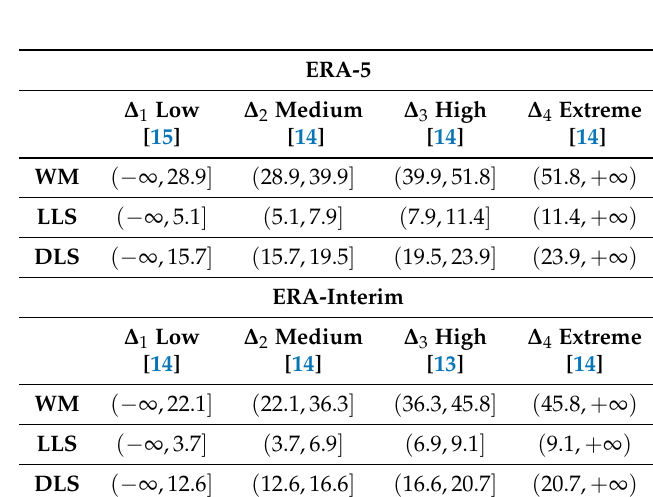
Table 1. The sub-intervals ∆ i ’s used to partition the ranges spanned by WM, LLS, and DLS, for both the ERA-5 and the ERA-Interim datasets: the units are in m/s. The values in brackets indicate the number of tornadoes recorded in each